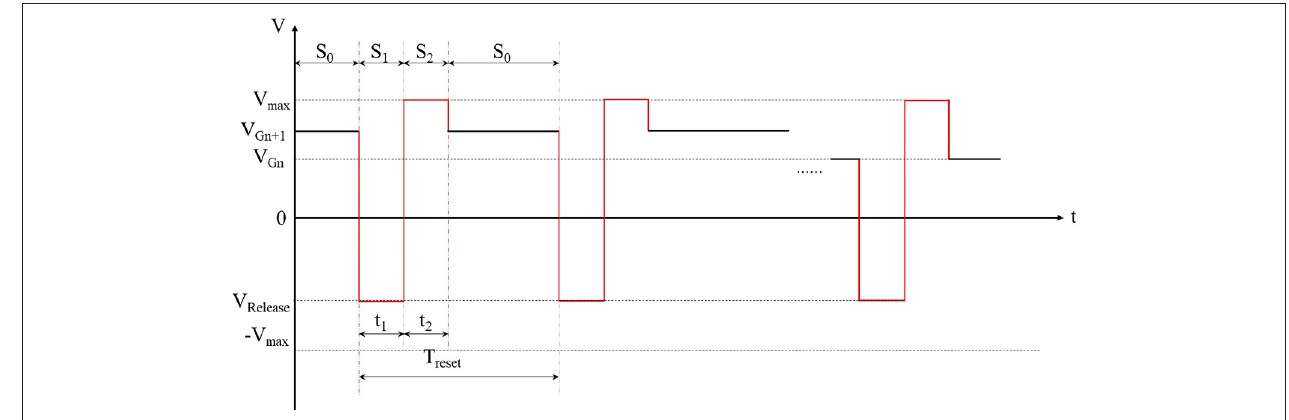
FIGURE 7 | The diagram of driving waveform with a reset signal introduced. It can be used to reduce the influence of oil backflow in EWDs.